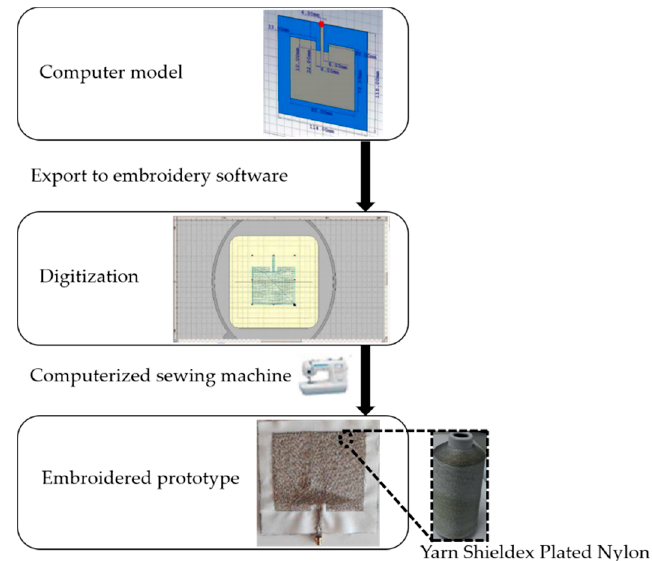
Figure 7. Embroidery process, reproduced with permission from [90].